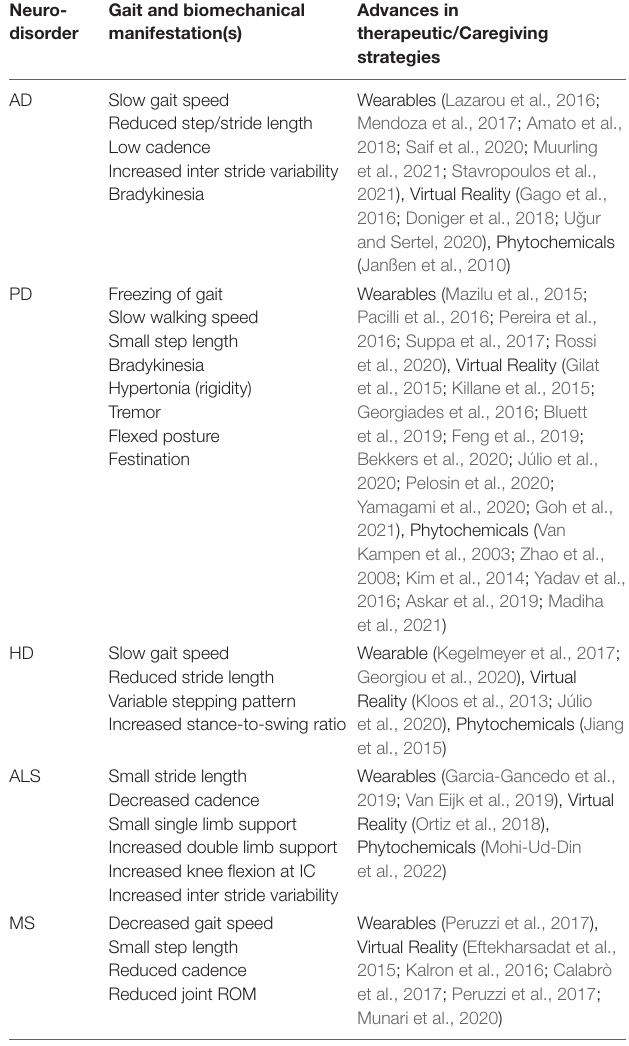
TABLE 3 | Current progress in non-pharmacological therapeutic and rehabilitation measures for neurodegenerative gait and motor functions. Neuro-